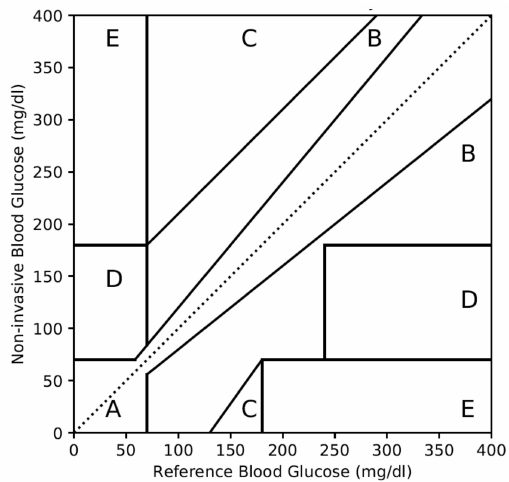
Figure 1. Clarke error grid analysis (CEGA) plot with di ff erent zones.